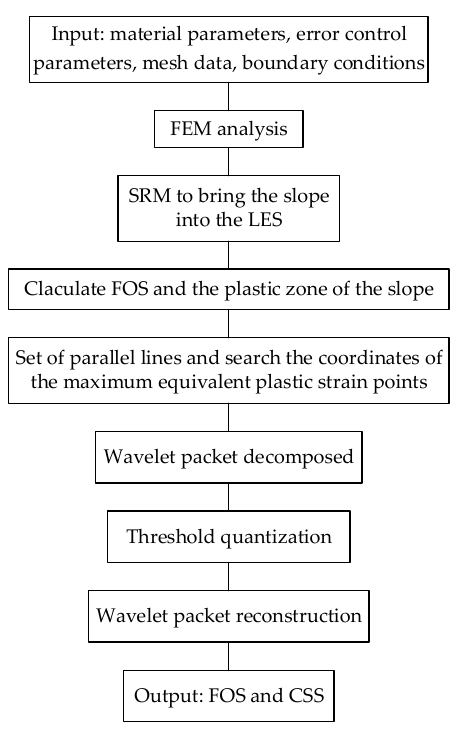
Figure 2. Flow diagram for the proposed method.